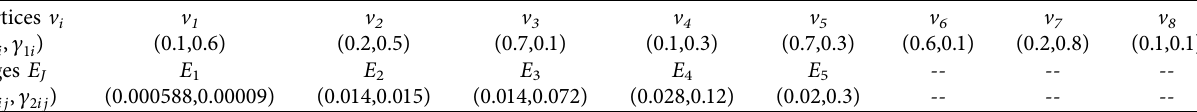
Table 12: Degree of membership and nonmembership values for vertices and edges of Figure